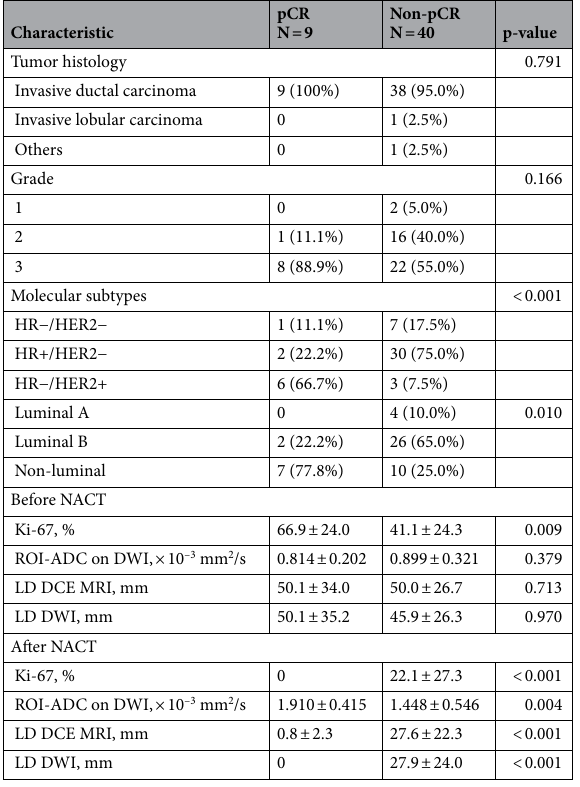
Table 3. Tumor characteristics of the study population according to pathologic complete response. HER2 human epidermal growth factor receptor 2, HR hormone receptor, pCR pathologic complete response, Ki-67 Ki-67 proliferation index, NACT neoadjuvant chemotherapy, ROI region of interest, ADC apparent diffusion coefficient, LD largest diameter, DCE-MRI dynamic contrast-enhanced magnetic resonance imaging, DWI diffusion-weighted